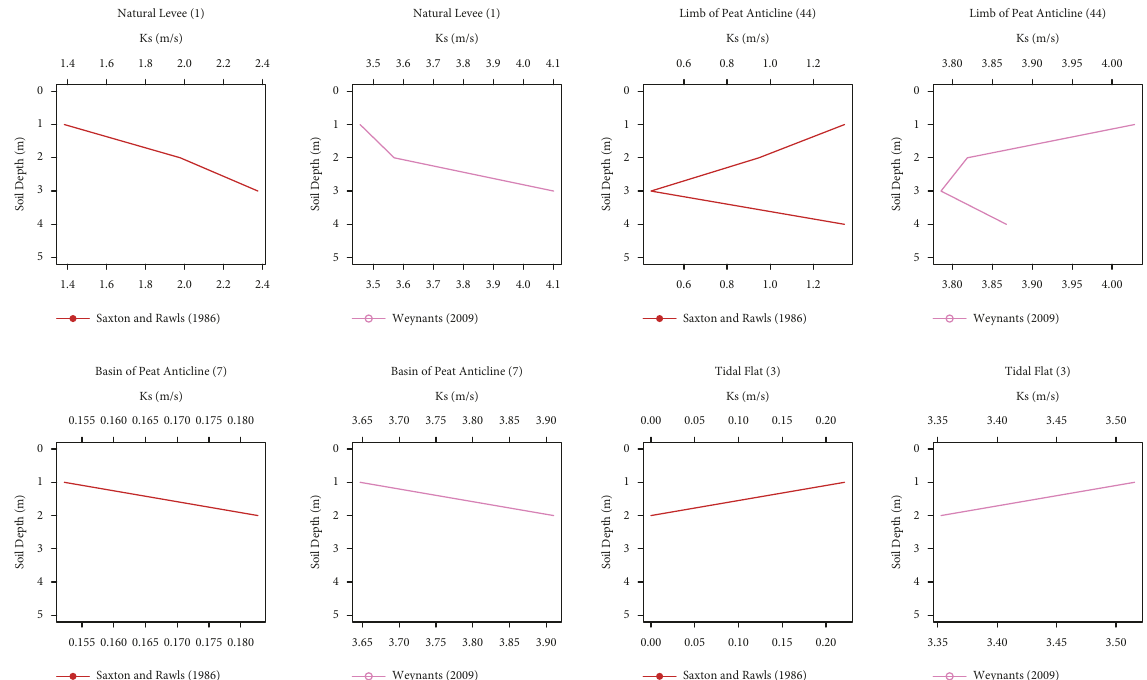
Figure 10: Comparison of K s profile along soil depth in different landforms in Barito Delta applying Saxton and Rawls (1986) vs Weynants et al.